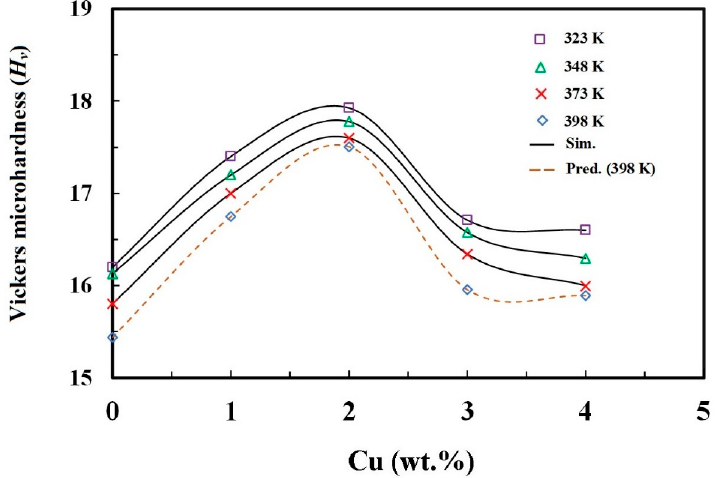
Figure 13. Simulation and prediction of the hardness-profile of Sn-Zn-Cu alloys based-ANN model .